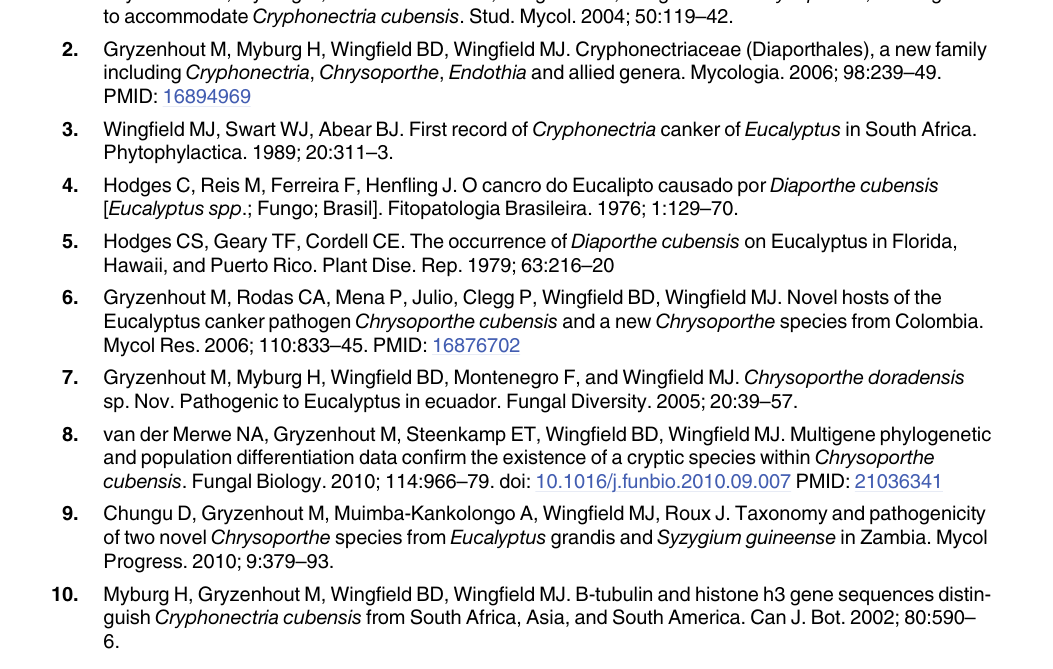
S3 Table. BLAST analysis of all identified introns against mt genome sequences deposited in NCBI GenBank. The best hits for each query (intron) is shown. Default BLAST parameters were used. The prefix CA, CC, CD and CP is added to the intron names for clarity. S4 Table. BLAST analysis of identified intron encoded and free standing HEG protein sequences. Results from all possible comparisons were calculated. Only Blast hits with a threshold of over 50% alignment coverage, 50% sequence identity and E-value of 0.00005 are shown. S5 Table. BLAST analysis of intronic and free standing HEG protein sequences against mt genomes deposited in NCBI GenBank database. HEG type were annotated using the NCBI Conserved Domain Database